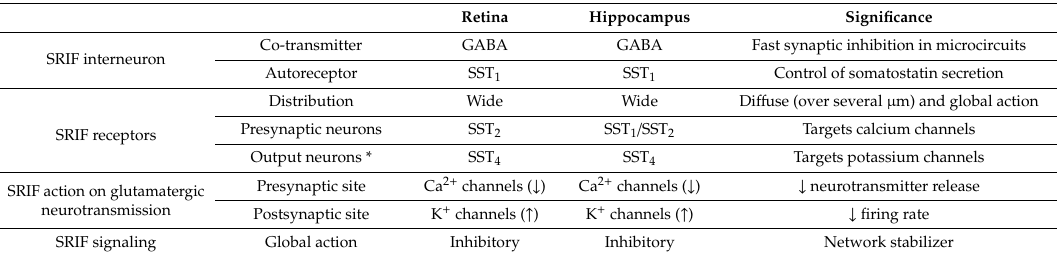
Table 3. The somatostatinergic system in the retina and hippocampus: shared properties and mechanisms ( ↑ : potentiation; ↓ : reduction) along the main line of information transfer (retina: RP → RBC → GC; hippocampus: DG → CA3 → CA1). Retina Hippocampus Significance Co-transmitter GABA GABA Fast synaptic inhibition in microcircuits SRIF interneuron Autoreceptor SST 1 SST 1 Control of somatostatin secretion Distribution Wide Wide Di ff use (over several µ m) and global action Presynaptic neurons Targets calcium channels SRIF receptors Output neurons * Targets potassium channels Presynaptic site ↓ neurotransmitter release SRIF action on glutamatergic neurotransmission Postsynaptic site K + channels ( ↑ ) K + channels ( ↑ ) ↓ firing rate SRIF signaling Global action Inhibitory Inhibitory Network